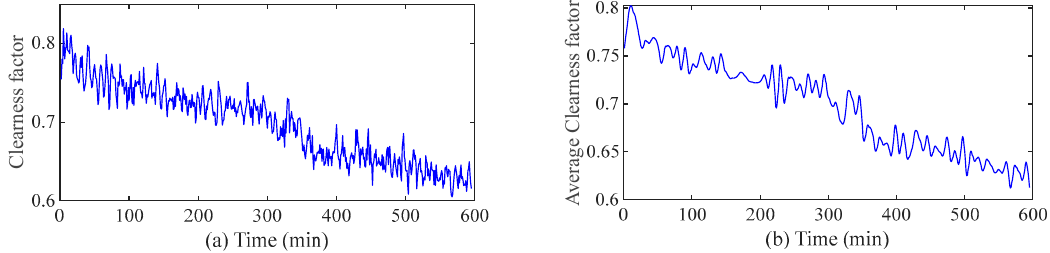
Figure 2. Contrast picture of the CF data before ( a ) and after ( b ) pretreatment.